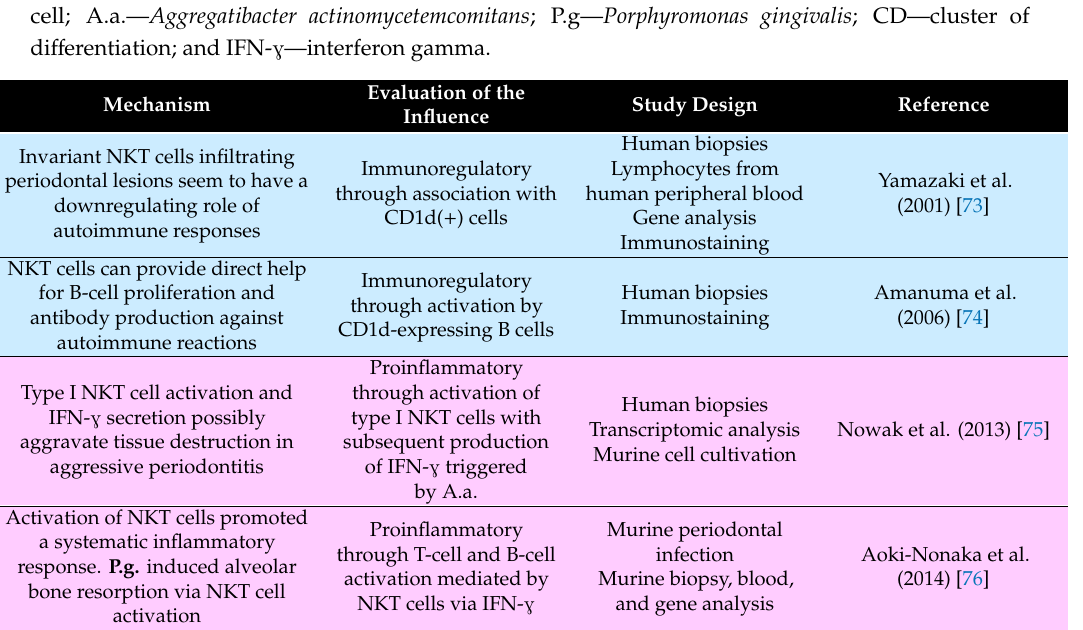
NKT cell-mediated mechanisms in periodontitis. NKT—natural killer T cell; A.a.— Aggregatibacter actinomycetemcomitans ; P.g— Porphyromonas gingivalis ; CD—cluster